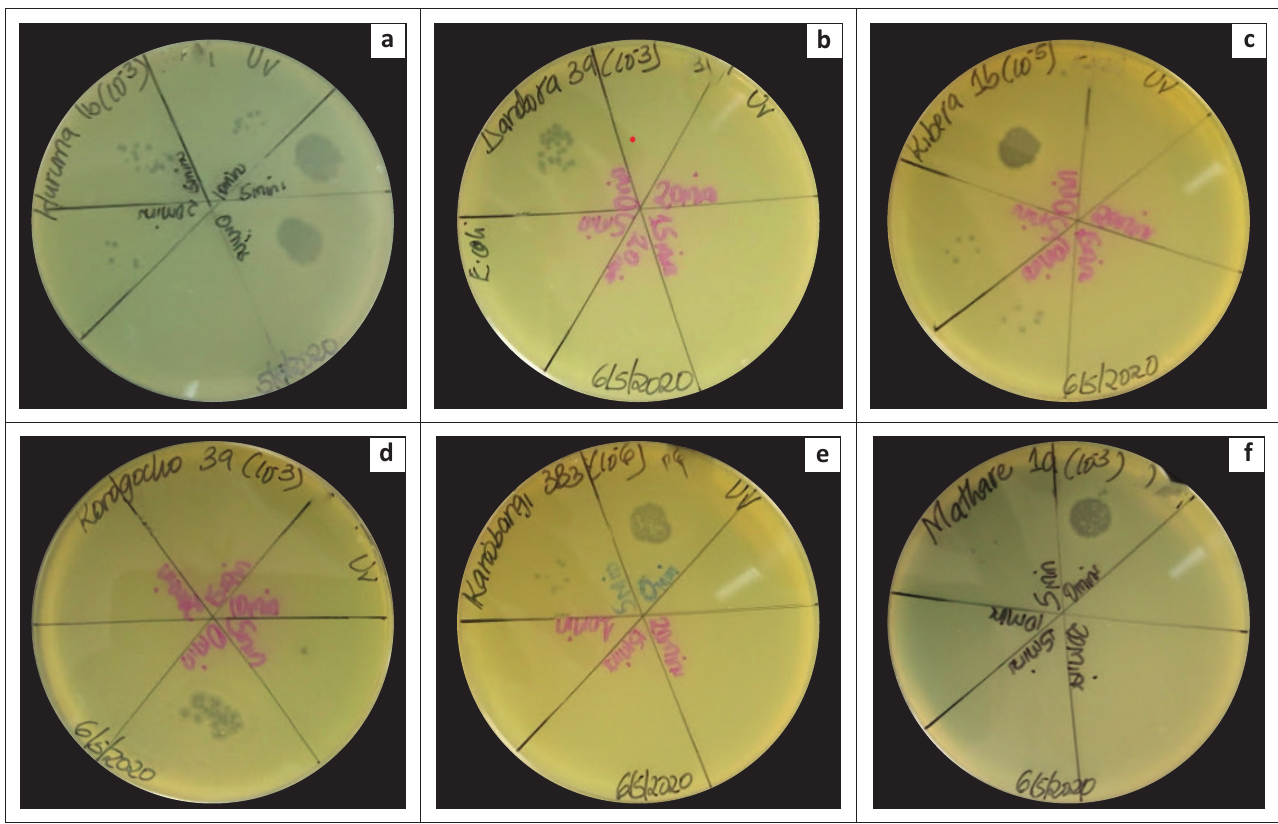
FIGURE 5: Effect of ultraviolet light exposure on phage survivability isolated in Nairobi County, Kenya, July 2019 to December 2020. The plates show the effect of ultraviolet light exposure from 0 min, 5 min, 10 min, 15 min and 20 min on: (a) Huruma 1b phage, (b) Dandora 3a phage, (c) Kibera 1b phage, (d) Korogocho 3a phage, (e) Kariobangi 3b3 phage, and (f) Mathare 1a phage isolated in Nairobi County, Kenya, between July 2019 and December 2020. The selected phages had decreased activity with increase in time from the 5th min to the 15th min, and no activity at all at the 20th min because all the phages had been destroyed.